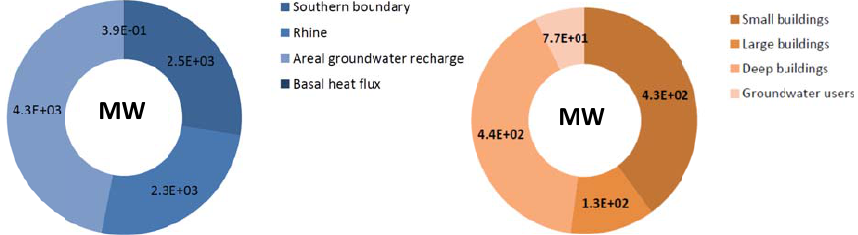
Fig. 8. Cumulative heat fluxes for 2010. Left panel: heat fluxes of natural boundaries (the influence of the basal heat flux is negligible). Right panel: heat fluxes of anthropogenic